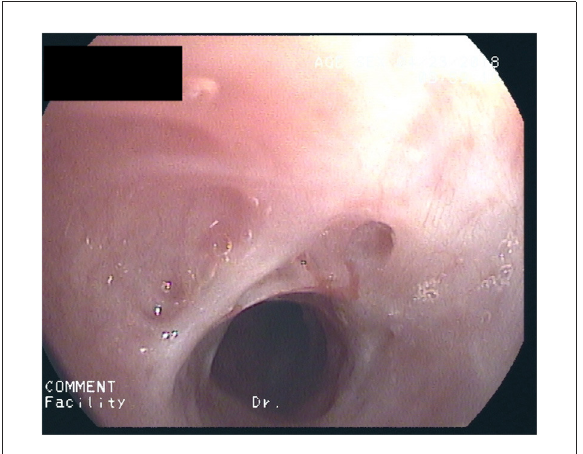
FIGURE1 Trachea at start of macrolide-therapy: Thick fibrous strands and marked stenosis.